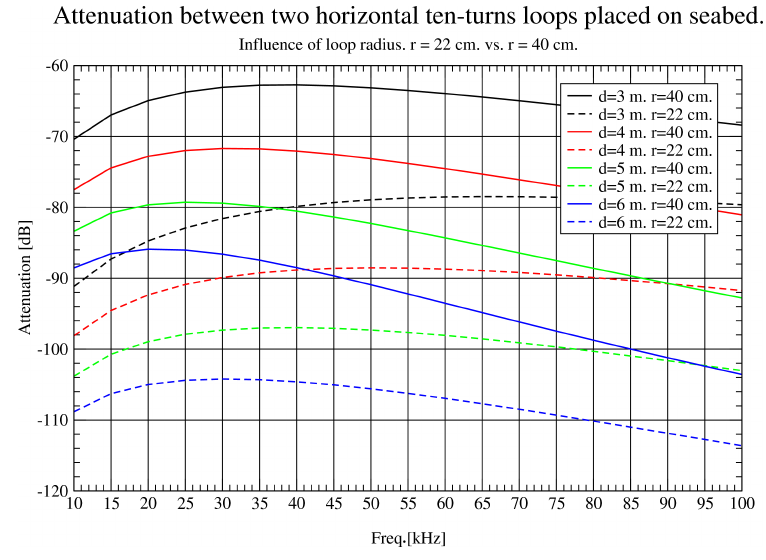
Figure 8. Influence of loop radius (10 KHz–100